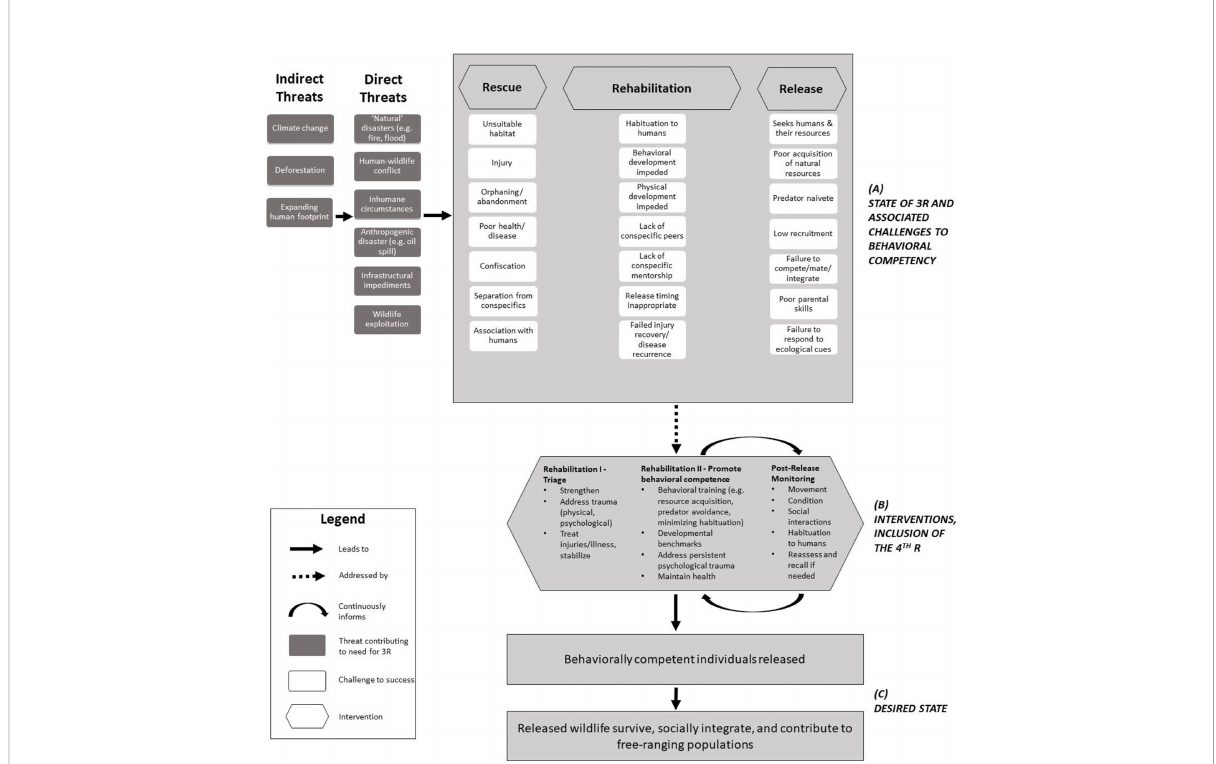
FIGURE 1 (A) Generalized situation model (CMP, 2020) of rescue-rehab-release. During rehabilitation, several factors may contribute to post-release behavioral incompetence, which may contribute to poor outcomes. These are overlapping considerations for conservation breeding and headstarting. (B) Targeted transition during Rehabilitation from triage activities (I) to interventions that promote behavioral competence (II). Post-release monitoring builds on Rehabilitation II interventions and is iterative and adaptive. Incorporating the 4th R, research, is essential for achieving (C) the desired state for rescued and released